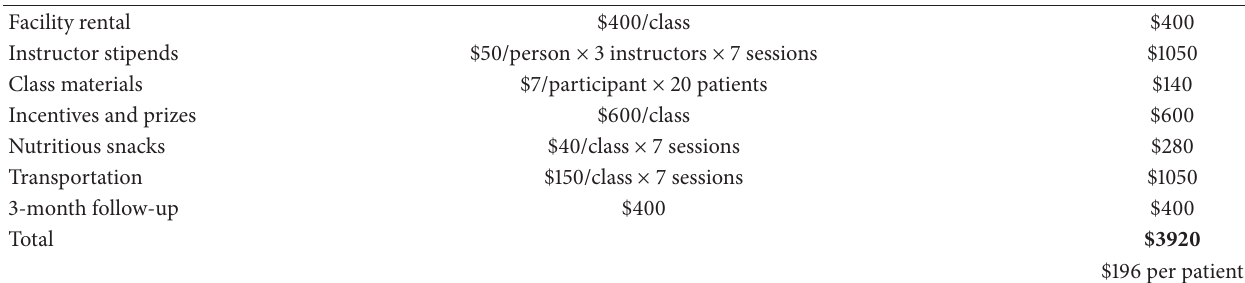
Table 4: Approximate expenses to conduct a FitKids360